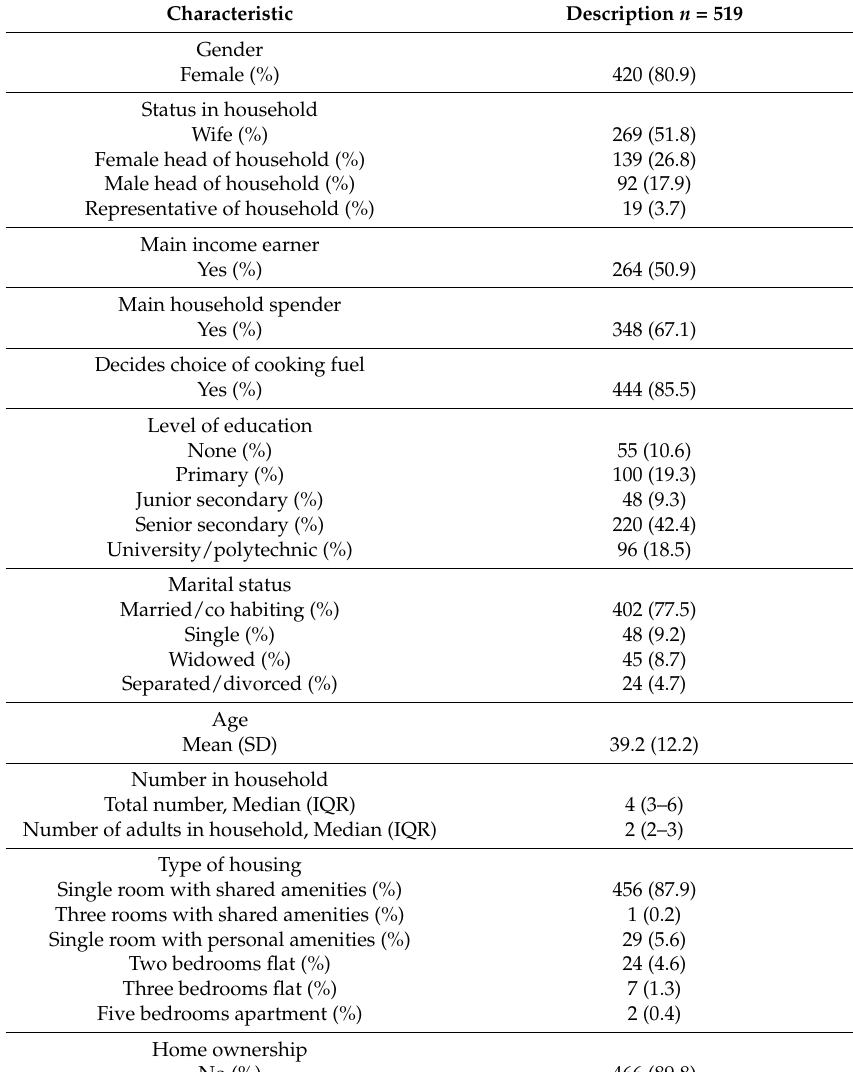
Table 1. Socio-demographic characteristics of all